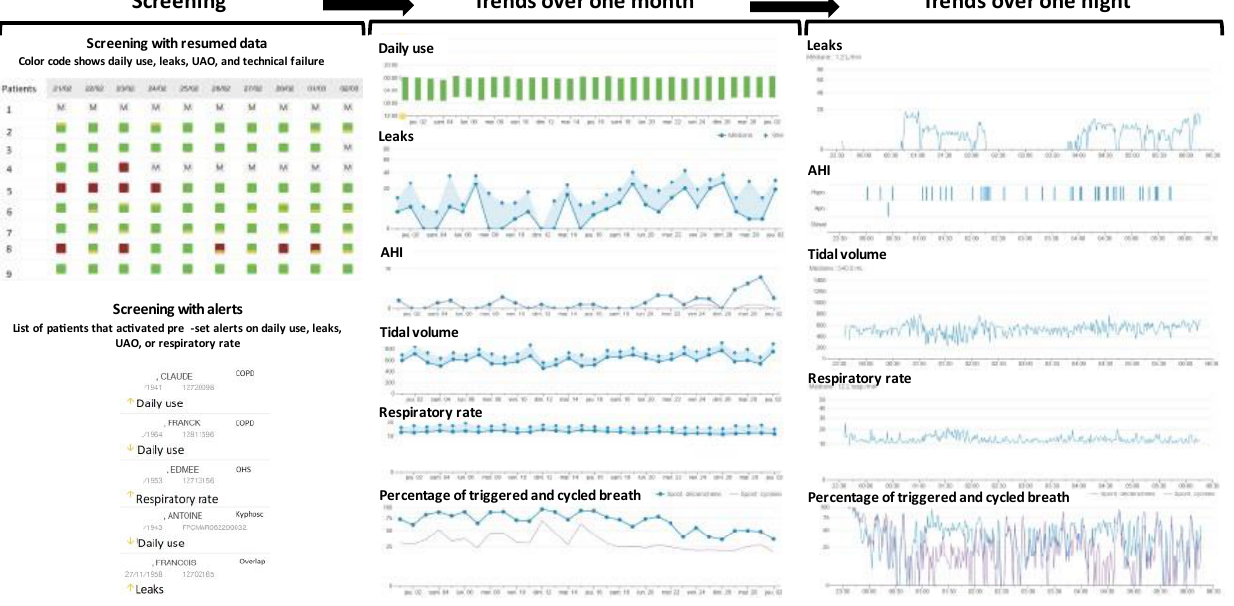
Figure 10. Telemonitoring of NIV. The workflow starts by screening the patients with abnormalities and focuses on trends over one month and one night. Green and red square inform about the daily use above or below 5 h per day, respectively. AHI: Apnea Hypopnea Index.